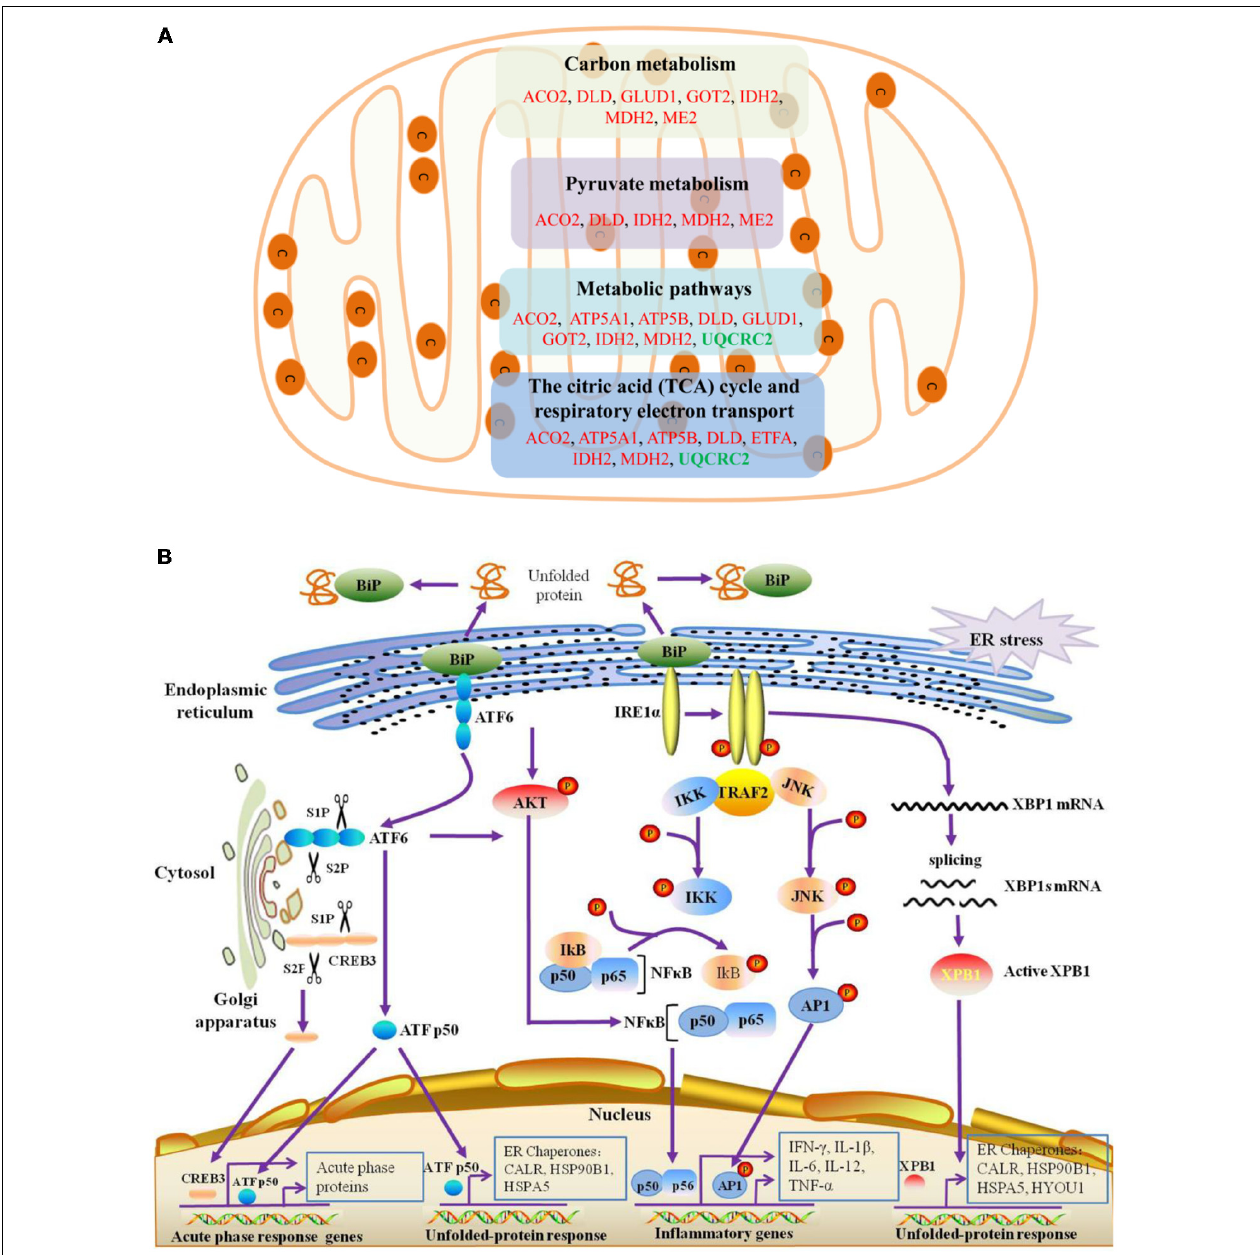
FIGURE 5 | Mitochondrial, endoplasmic reticulum (ER)-stress, unfolded protein response (UPR), inflammatory response and acute phase response pathways are associated with differentially expressed proteins. (A) The differentially expressed proteins belonged to mitochondrial proteins are mainly divided into four categories, which are associated with different pathways. (B) ER-stress, UPR, acute phase response pathways are shown. ATF6 and IRE1 α pathways may be involved in the unfolded-protein response and inflammatory response of PBMCs in autistic children. Upon dissociation from BiP in response to ER stress, ATF6 translocates to the Golgi apparatus, where it is cleaved by the proteases site-1 protease (S1P) and S2P. This process results in the release of a functional (bZIP-containing) fragment of ATF6 into the cytosol. This fragment then migrates to the nucleus and activates transcription. In response to ER stress, IRE1 α autophosphorylates, thereby activating its RNase activity and splices XBP1 mRNA to spliced XBP1 mRNA, which codes for a transcription factor XBP1s that translocates to the nucleus and regulates genes involved in UPR and ER-associated degradation (ERAD). In addition, ATF6 can also trigger NF κ B-mediated inflammation via Akt kinase phosphorylation (pAkt). IRE1 α induces the expression of inflammatory genes through the activation of the JNK-AP1 and NF- κ B-I κ -B pathways. Moreover, active ATF6 and CREB3 can induce the transcription of acute phase response genes. CREB3 is cleaved by the Golgi resident proteases S1P and S2P. This protein fragment then transits from the cytosol to the nucleus where it activates transcription of target genes. The differentially expressed proteins associated with ER stress, protein folding in ER, unfolded protein binding, ATF6 activates chaperones, XBP1s activates chaperones, IRE1alpha activates chaperones, CREB3 factors activate genes, and acute inflammatory response, are listed in Supplementary Tables S4 – S6